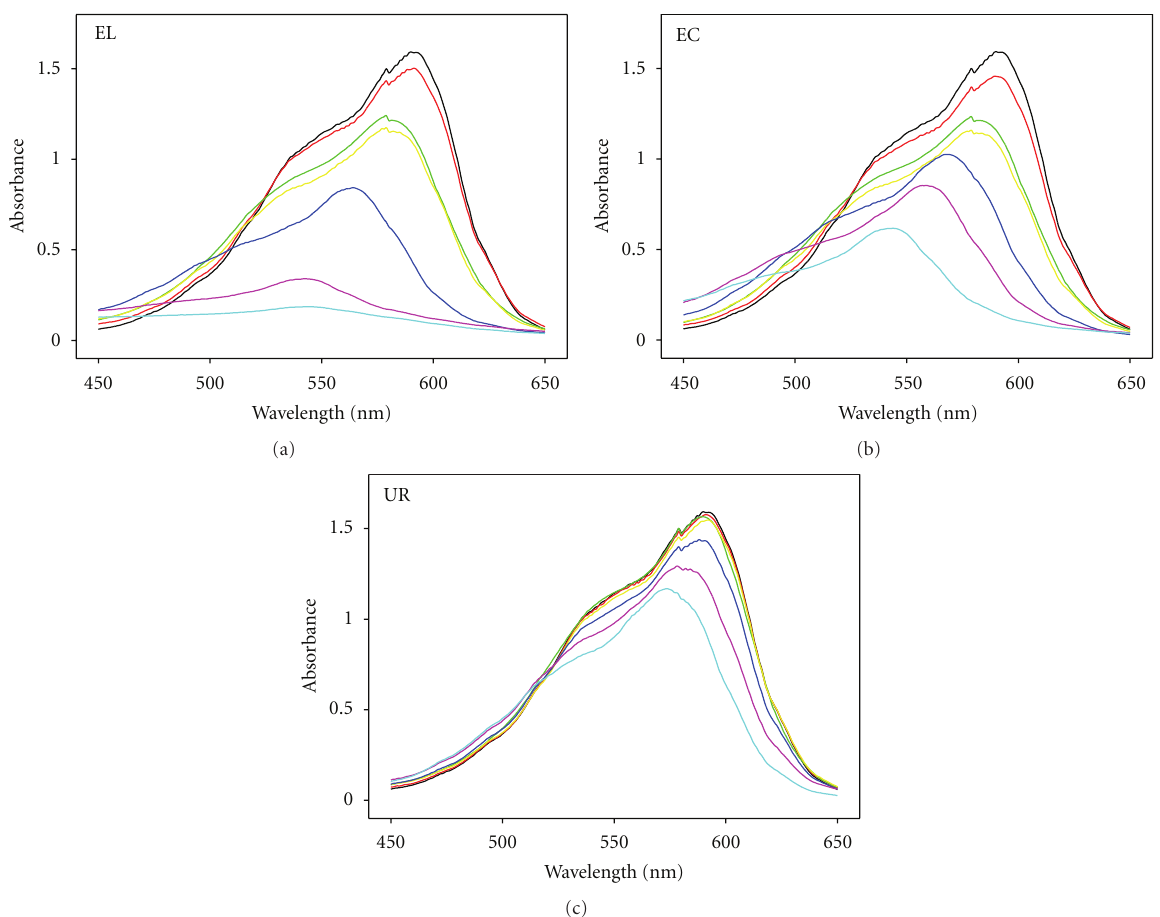
Figure 2: Decolorization of CV by three enzyme fractions (EL: extracellular liquid; EC: enzymatic crude; UR: ultrafiltration residue). Time of reaction: 0h (black), 0.5h (red), 2h (light green), 4.5 h (yellow), 1d (blue), 3 d (violet), 6d